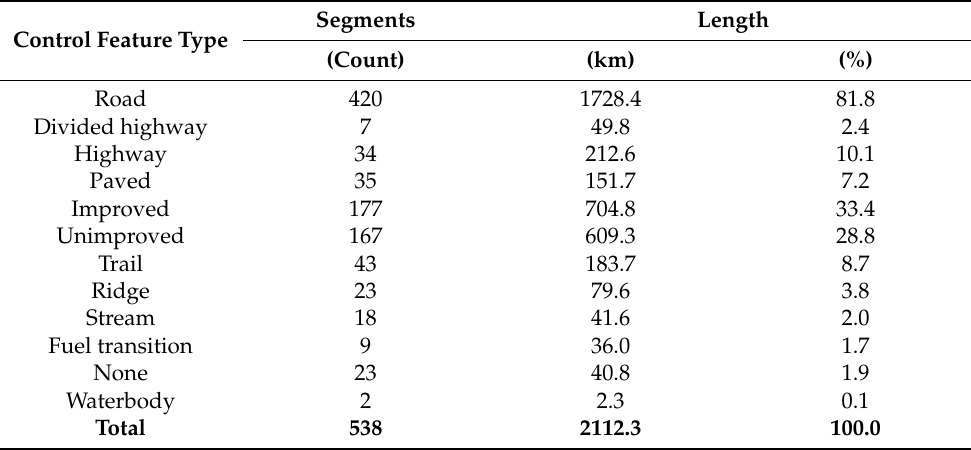
Table 1. Accounting of control features selected to bound potential wildland fire operational delin- eations (PODs) on the Canyon Lakes Ranger District (CLRD). Grey italics indicate subcategories of